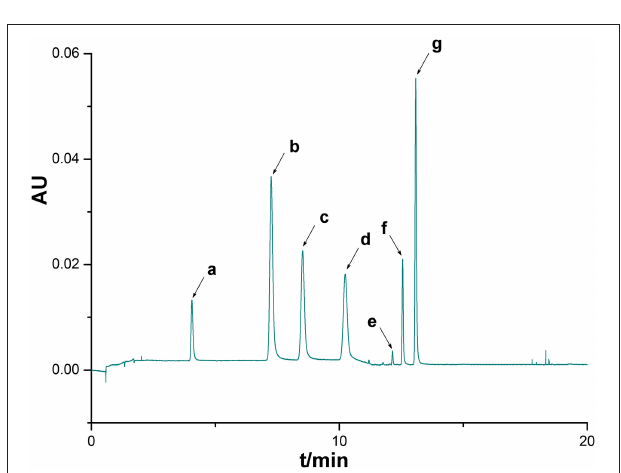
FIGURE 2 | UPLC chromatogram of a mixture of reference substances. Seven peaks were identified by comparison with standard substances: 5-Caffeoylquinic acid (a), Chlorogenic acid (b), 4-Dicaffeoylquinic acid (c), caffeic acid (d), Luteoloside (e), 3,4-Dicaffeoylquinic acid (f), 3,5-Dicaffeoylquinic acid